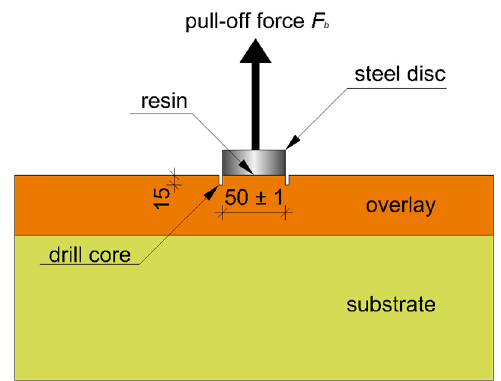
Figure 6. The scheme of the pull-off method according to subsurface tensile strength testing.